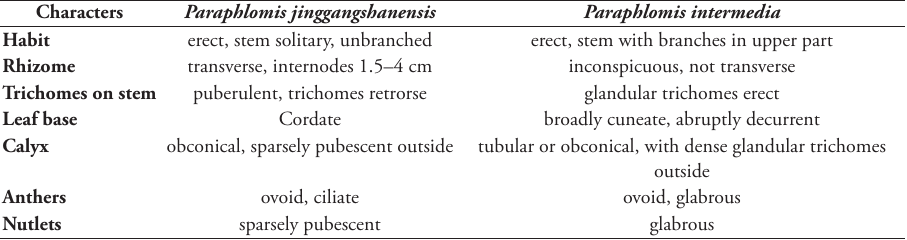
Table 2. Morphological comparison of Paraphlomis jinggangshanensis and Paraphlomis intermedia